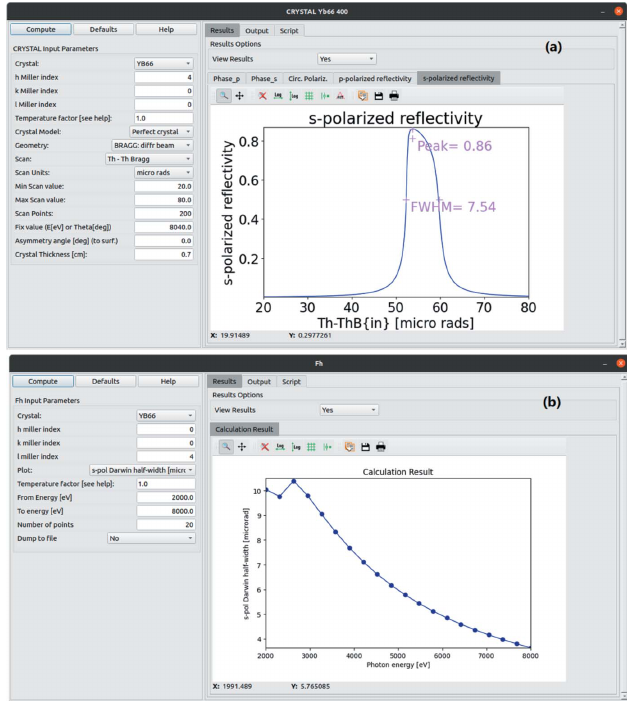
Figure 5 OASYS widgets CRYSTAL ( a ) and FH ( b ) with calculations of the reflection profile and Darwin widths for YB 66 .